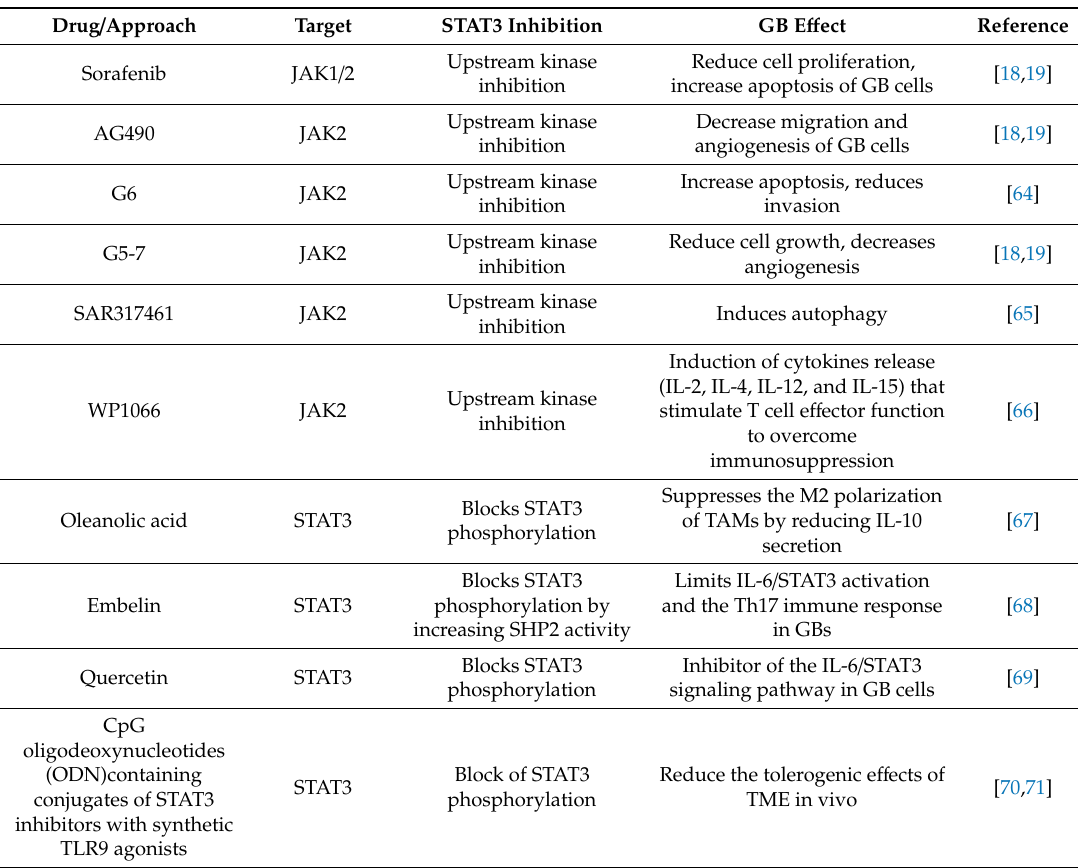
Table 2. Drugs / approaches targeting STAT3 activation in